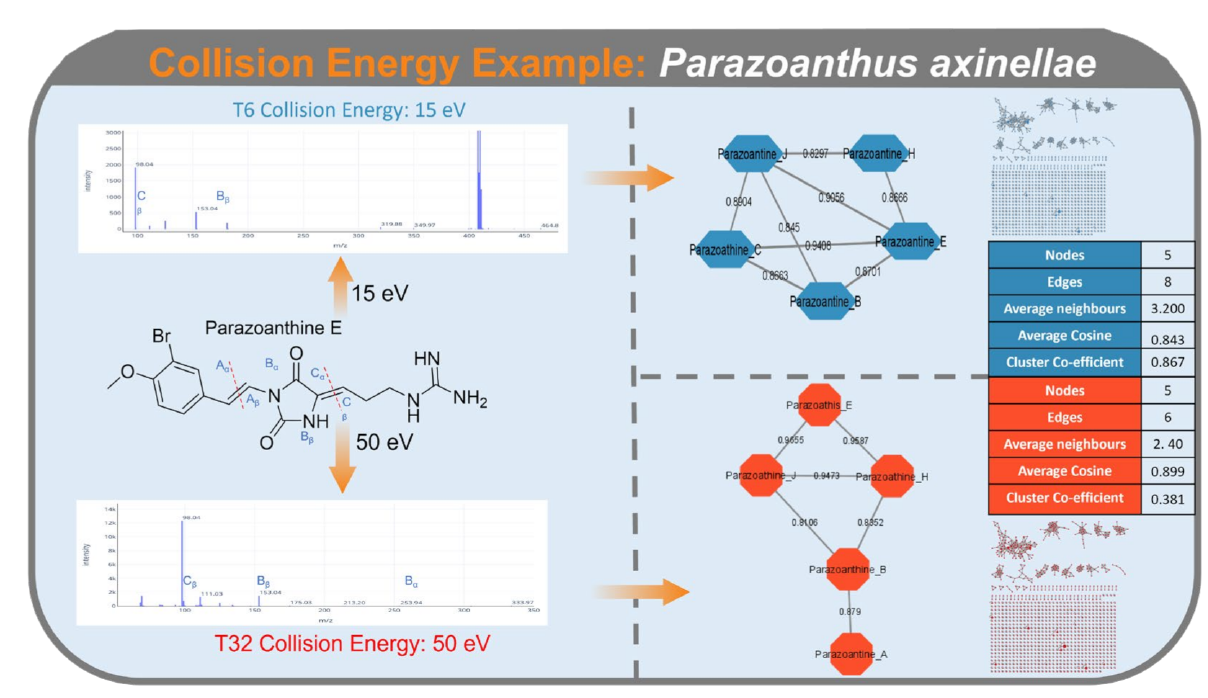
Figure 8. Fragmentation pattern and MS 2 spectra of parazoanthine E using a collision energy of 15 eV (top, blue, T6) and 50 eV (bottom, red, T32). Parazoanthine clusters with annotated nodes, resulting from a collision energy of 15 eV (top, blue, T6) and 50 eV (bottom, red, T32). Edges are labeled with cosine scores. Tables with cluster statistics under both conditions are displayed on the